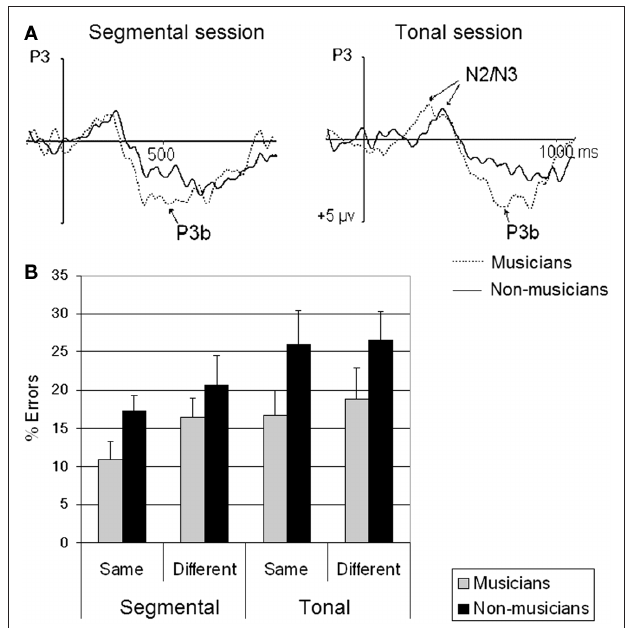
Figure 1 | (A) Difference-wave ERPs (different minus same final words) for the segmental (left) and tonal (right) sessions in musicians (dashed line) and non-musicians (solid line). (B) Percentage of errors for musicians (gray) and non-musicians (black) in the segmental and the tonal sessions and in the two experimental conditions (same and different words, with error bars). Adapted from Marie et al. (in